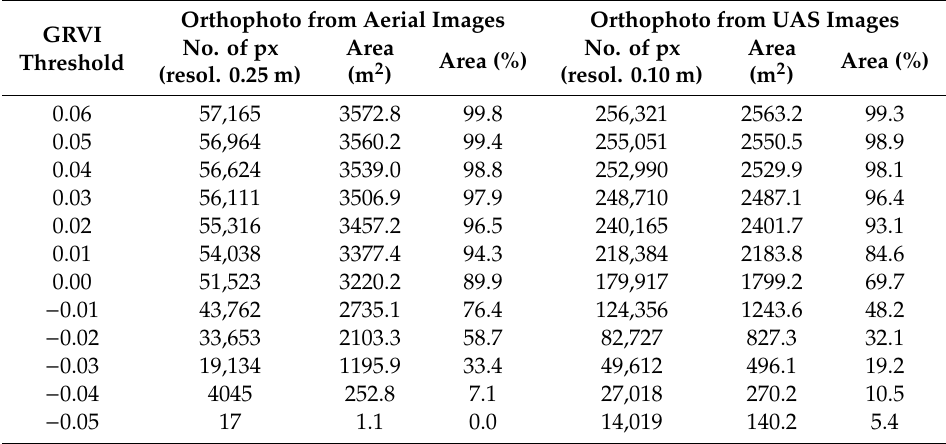
Table 2. Comparison of the detected unvegetation ground areas within reference polygons for different GRVI threshold values. Orthophoto from Aerial GRVI